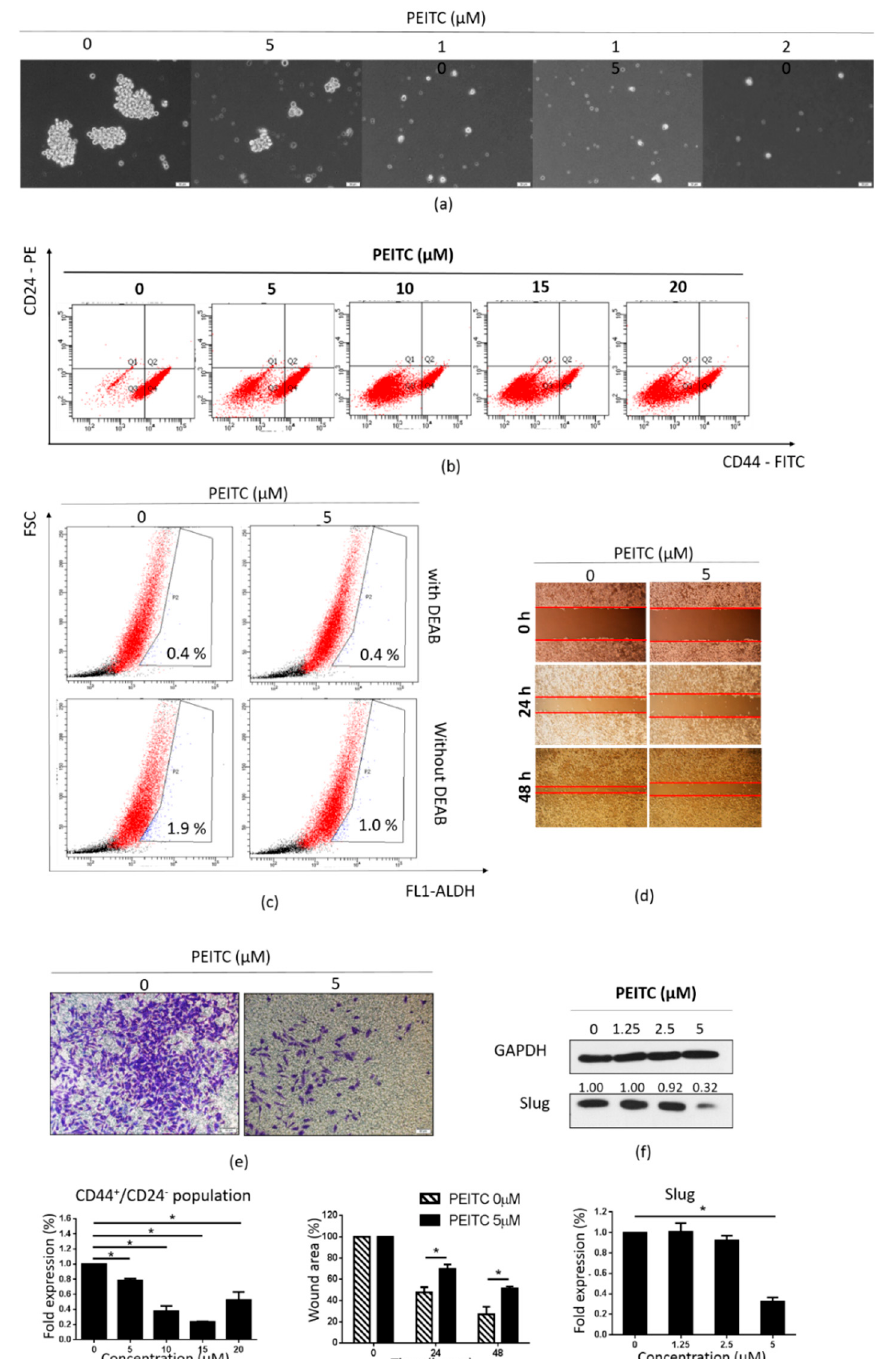
ff ects of PEITC on stemness in MDA-MB-231 / IR cells. ( a ) Mammospheres were cultured in Figure 6. Effects of PEITC on stemness in MDA-MB-231/IR cells. ( a ) Mammospheres were cultured in Figure 6. E complete MammoCult Human Medium (100 × magnification). ( b ) CD44 + / CD24 − populations